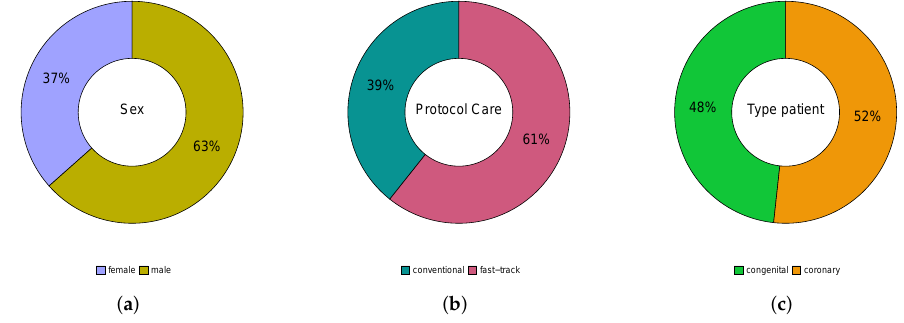
Figure 3. Pie charts of variables: gender ( a ), protocol care ( b ), and type of patient ( c